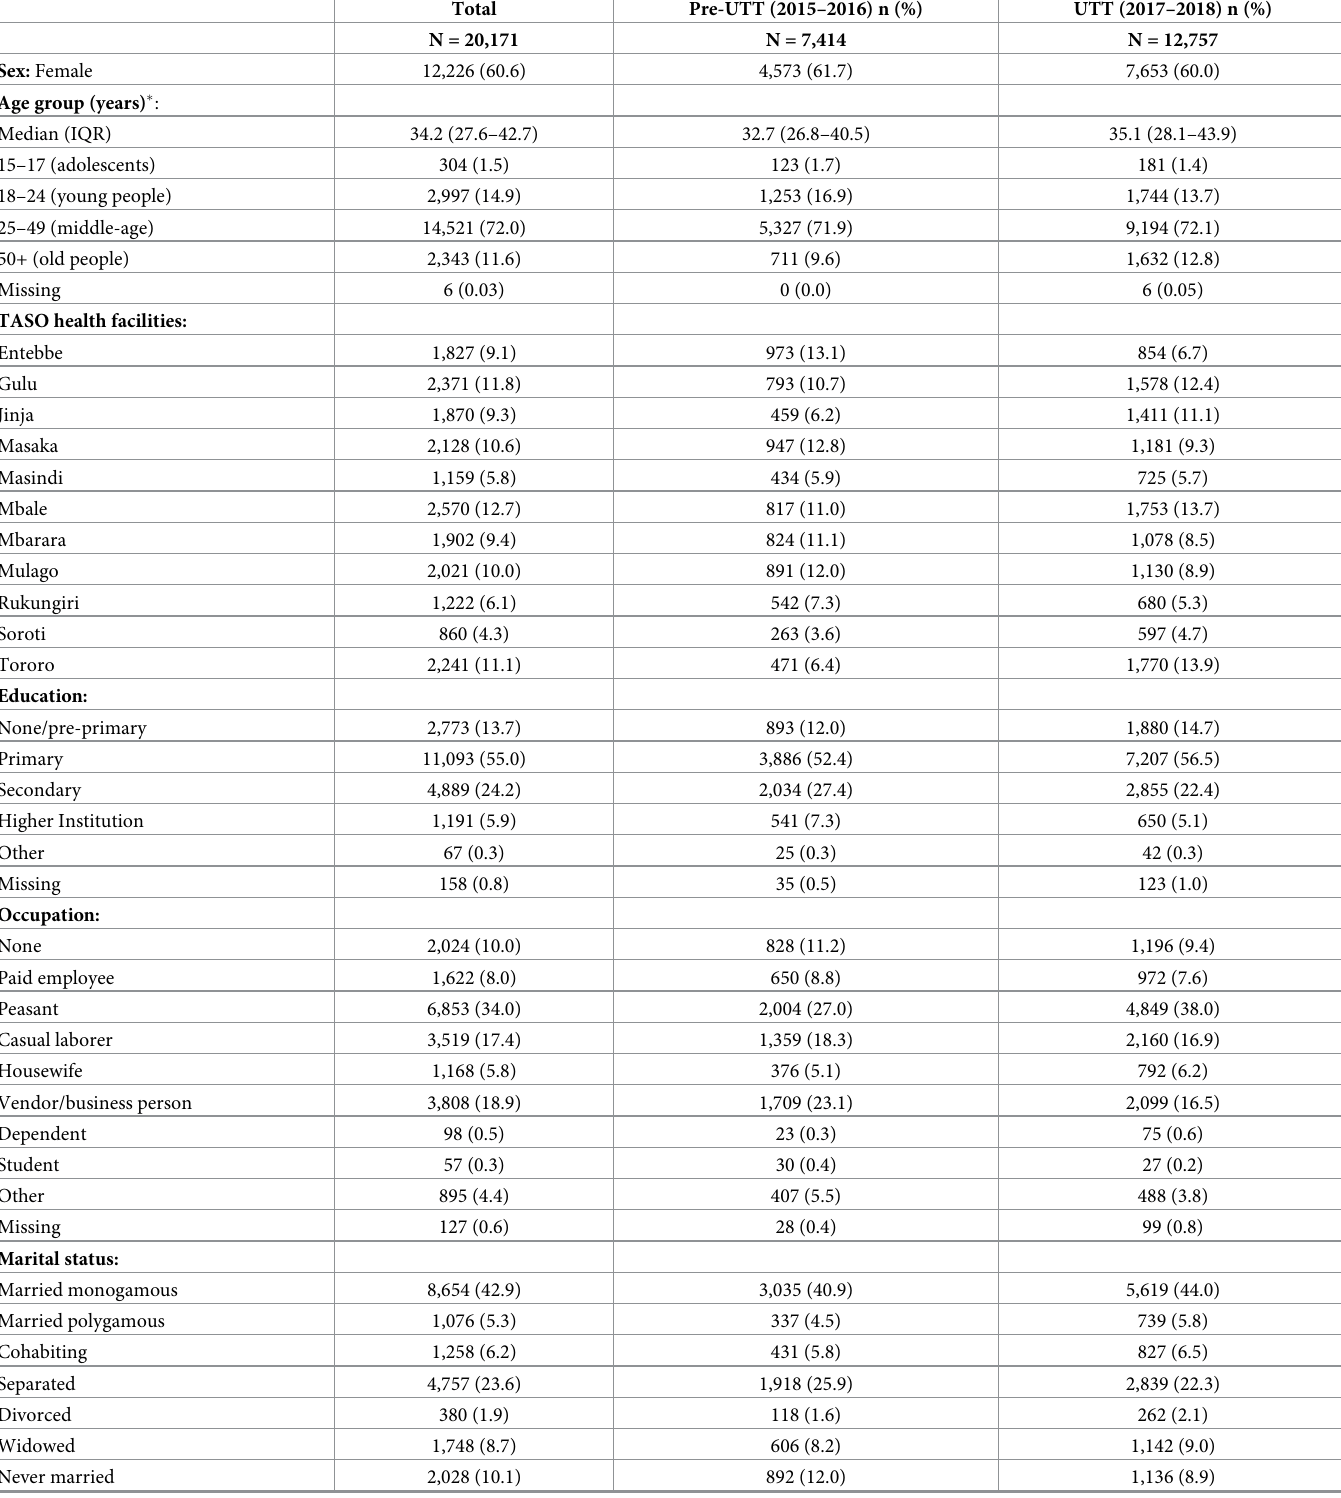
Table 1. Baseline characteristics of PLHIV enrolled during the two study periods, pre and during